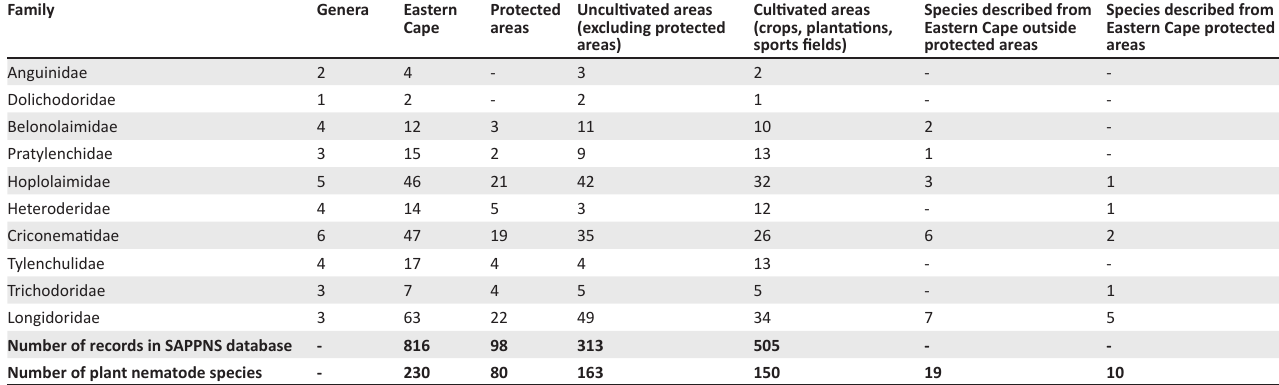
TABLE 1: Number of genera and species of plant nematodes recorded from the Eastern Cape. Family Genera Eastern Cape